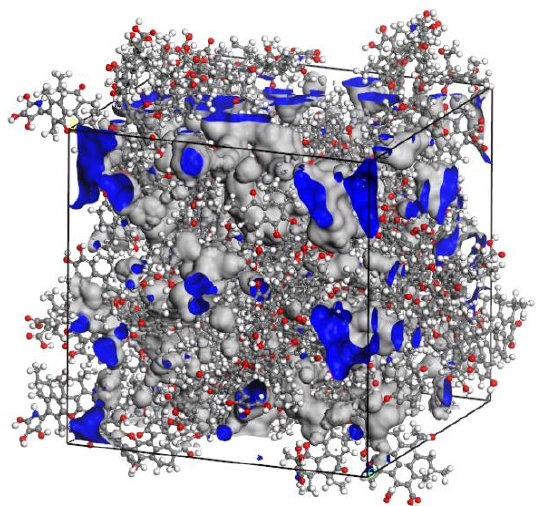
Figure 6. The 3D structure model of Bulianta coal (45 Å × 45 Å × 45 Å ).